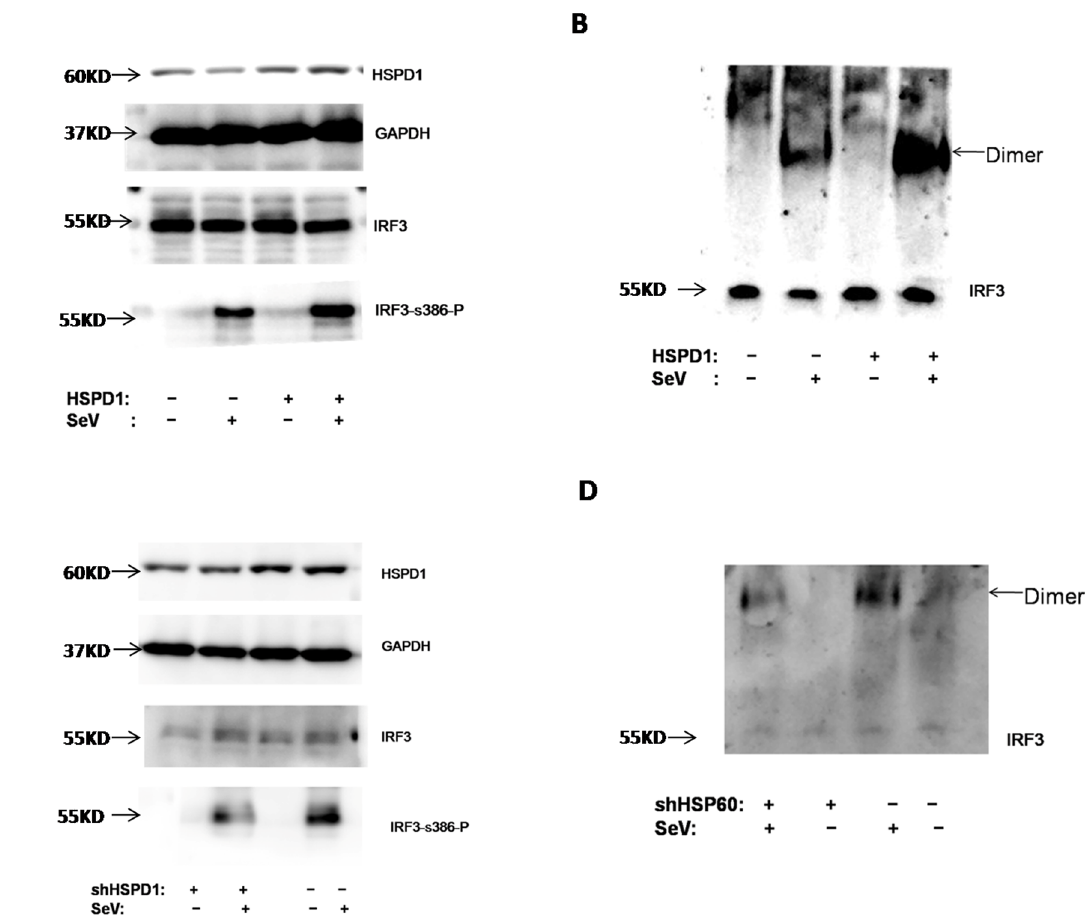
Fig. 6. Overexpression of HSPD1 facilitated the activation of IRF3. A and C. HEK293Tcells were transfected with plasmid encoding Myc-tagged HSPD1 or control vector, shRNA or control vector. After incubation for 24 h, the cells were infected with SeV. At 8 h post-infection, the proteins were extracted